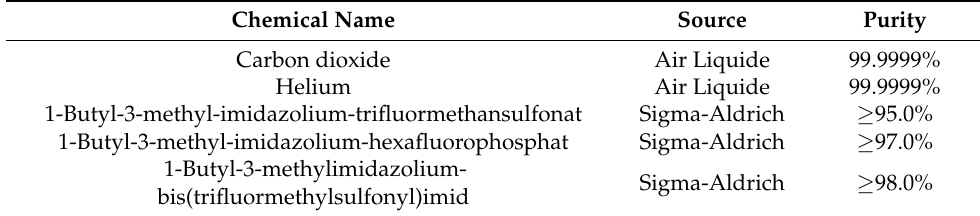
Table 1. Molar purities of the pure substances studied in the present